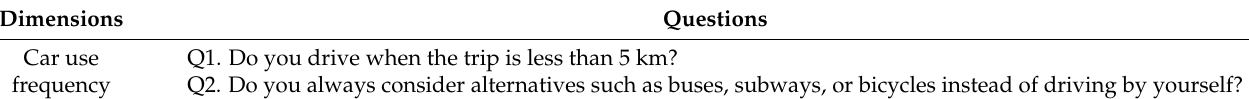
Table 3. Questions of the driving behavior